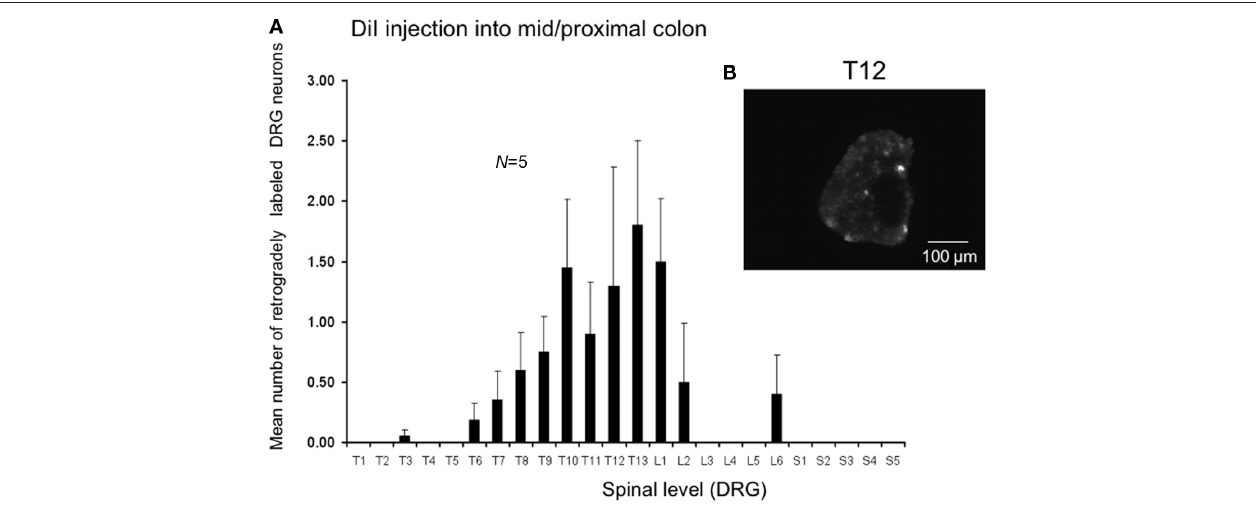
Figure 4 | Distribution of retrogradely labeled Drg neurons following injection of Dii into the mid to proximal colon. (A) DiI injected into the mouse colon 30–75 mm from the anus (measured in unstretched colon preparations, N = 5). DiI labeled neurons were primarily identified between T5 and L2, with peak labeling between T11-L1. Only one to four neurons on average were labeled in any DRG section. (B) Shows a fluorescence micrograph of labeled neurons at